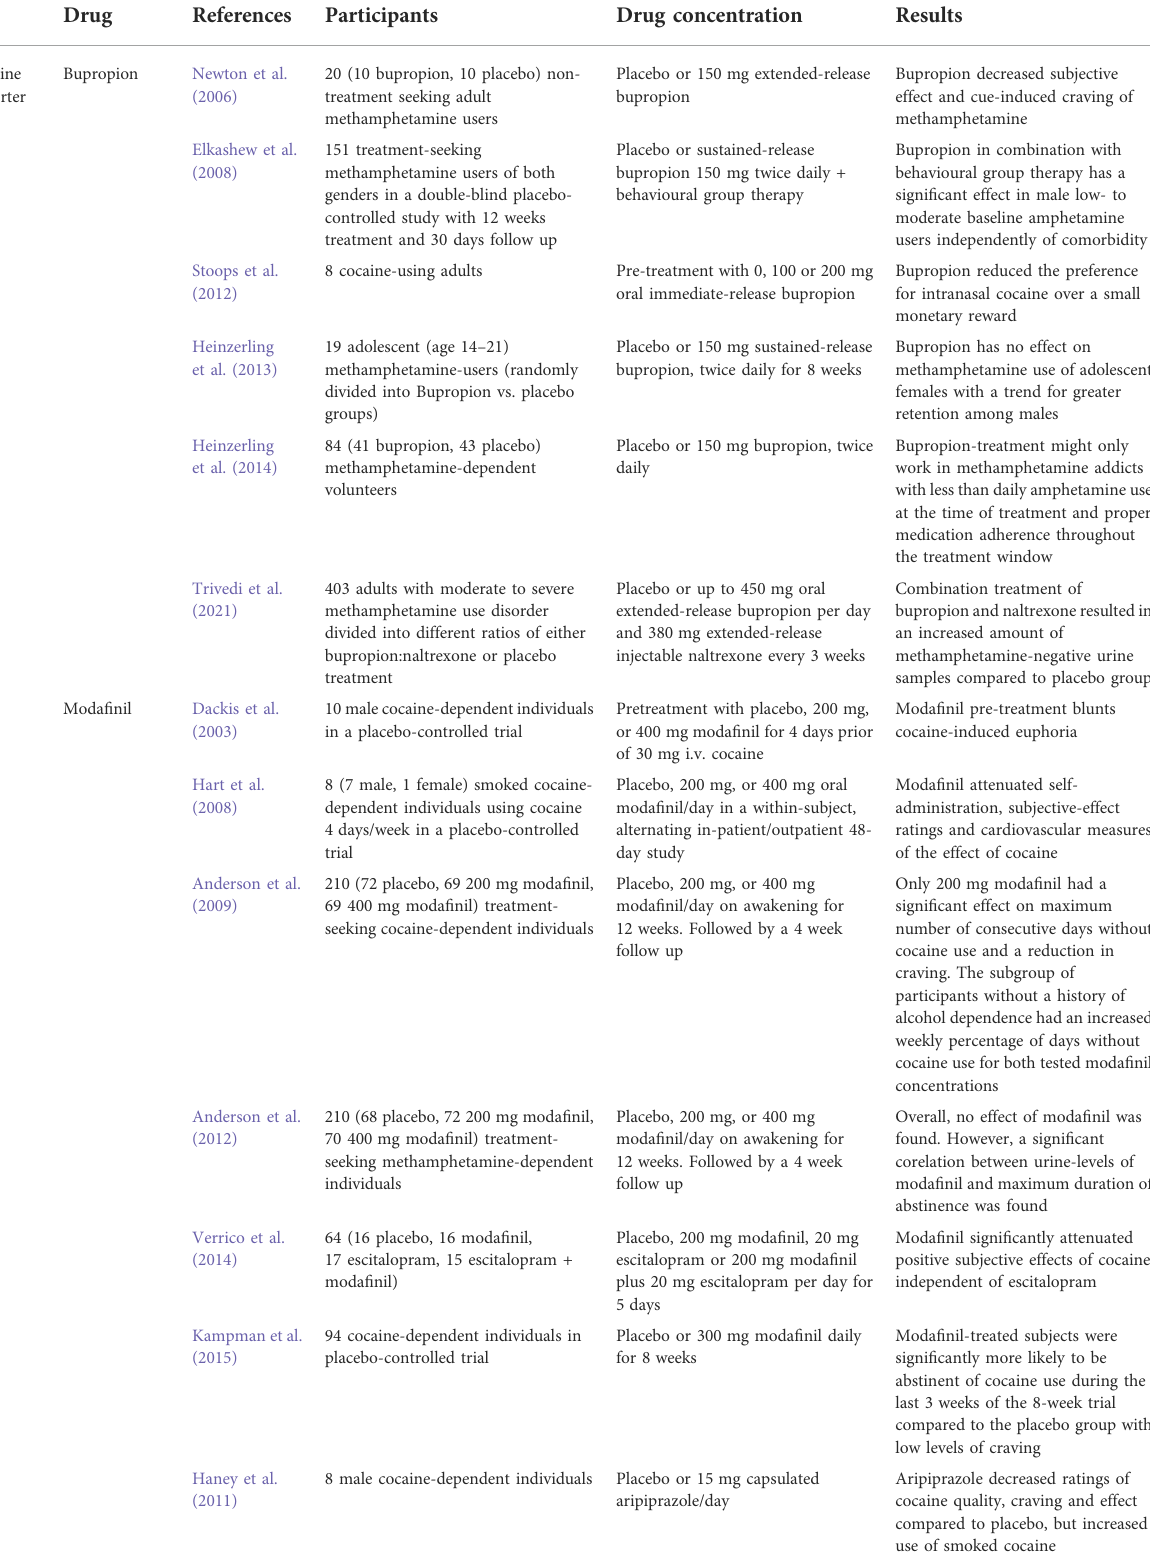
TABLE 1 Human studies with pharmacological targeting of the dopamine system to treat psychostimulant